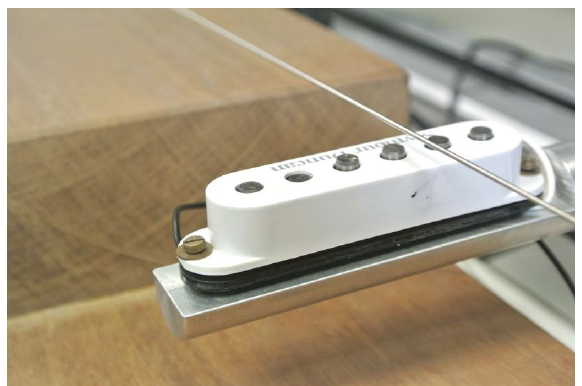
Figure 9. Picture of the second experiment in which the pickup is placed under a vibrating